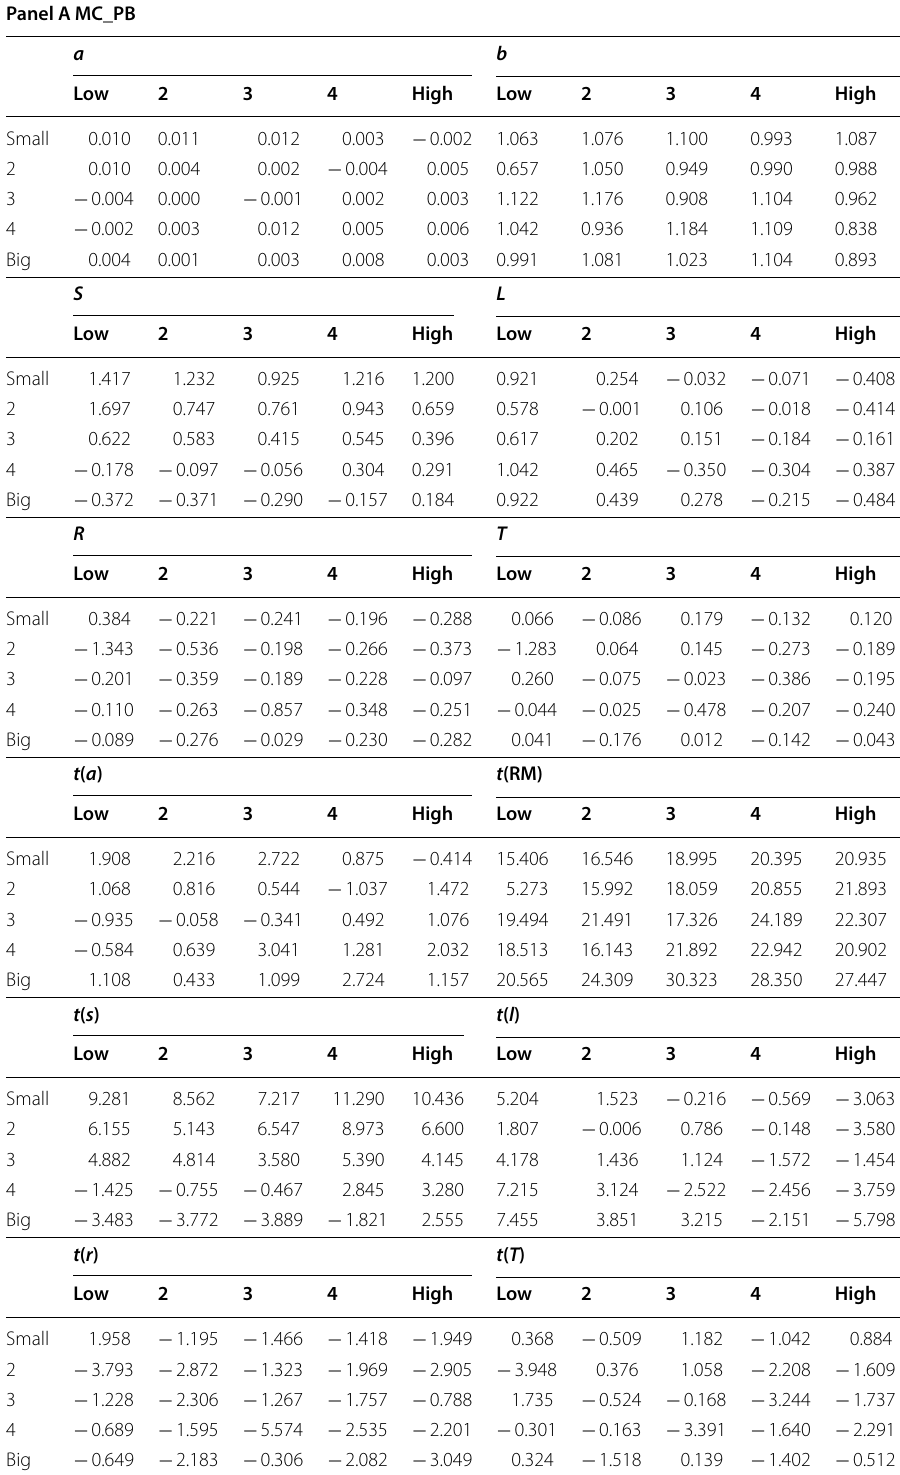
Table 5 Regression results of Fama–French five-factor model for 25